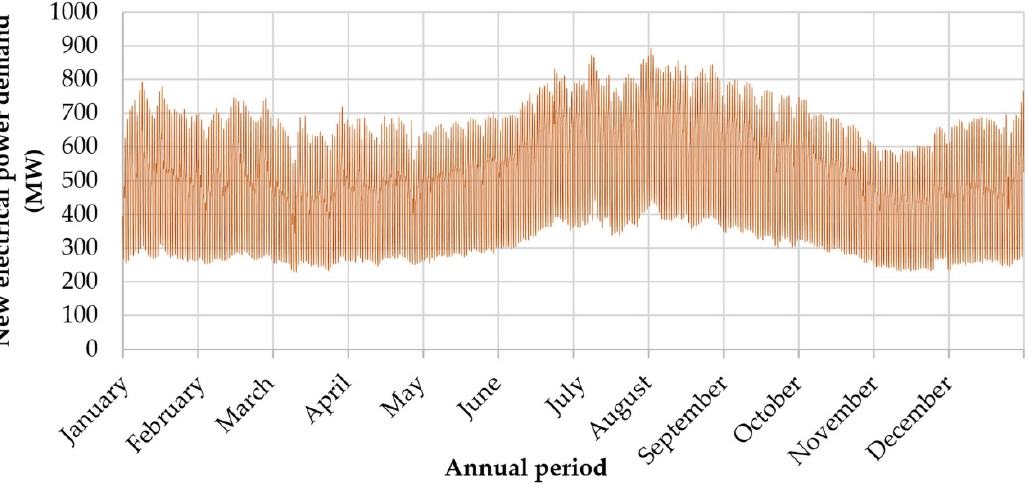
Figure 25. New annual power demand time series in Crete.